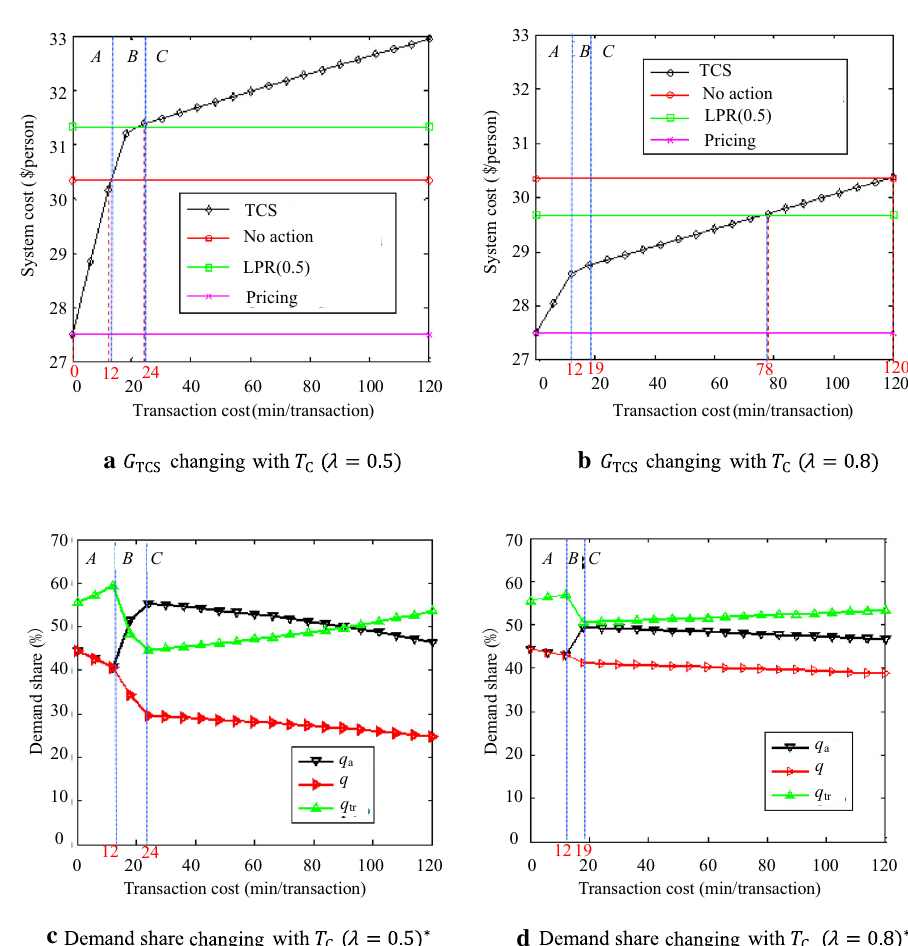
Fig. 2 Performances of DD-TCS with various T C . q is the highway flow, i.e. q ¼ q a k þ x ð Þ , which is converted into percentage by q indicates the demand of transit users, i.e. q tr ¼ d (cid:5) q a , converted into percentage by q tr